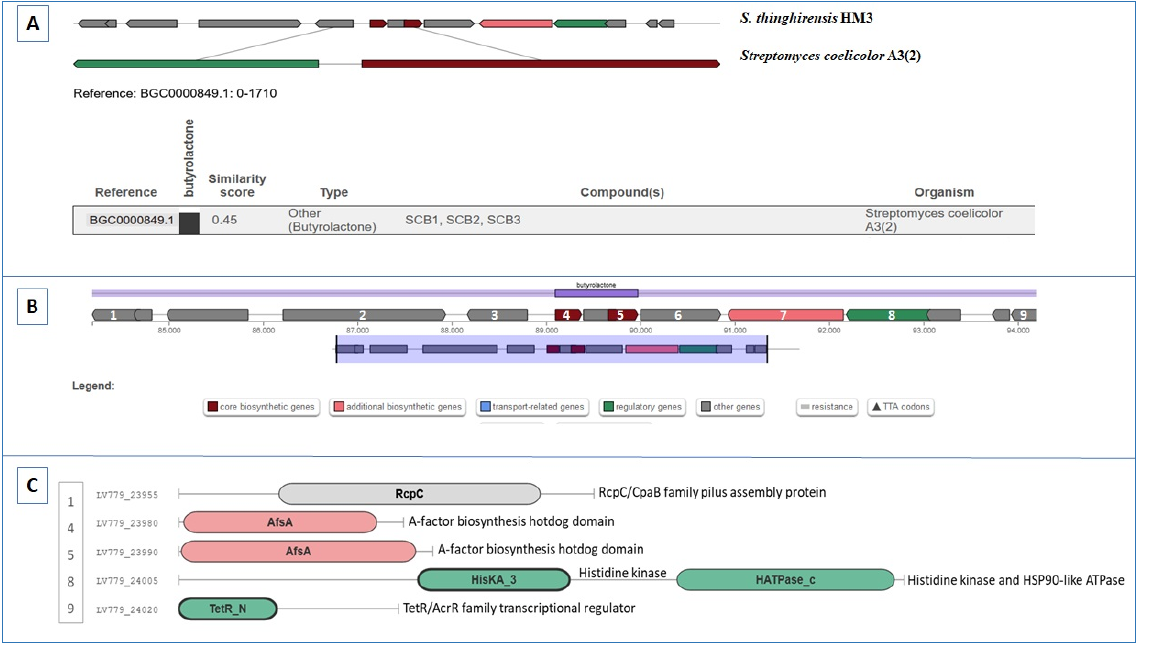
Figure 9. Butyrolactone biosynthetic gene cluster in S. thinghirensis HM3. ( A ) The MIBiG comparison between the proposed butyrolactone BGC in strain HM3 and the proposed identified cluster of SCB1 in S. coelicolor A3(2) recorded a similarity score of 0.45. ( B ) The proposed butyrolactone BGC in region 41.1 of the genome; 2, glycoside hydrolase family 18 protein; 3, TetR/AcrR family transcriptional regulator; 6, NAD(P)H-binding protein; 7, cytochrome P450. ( C ) represents the Pfam domains involved in butyrolactone biosynthesis.